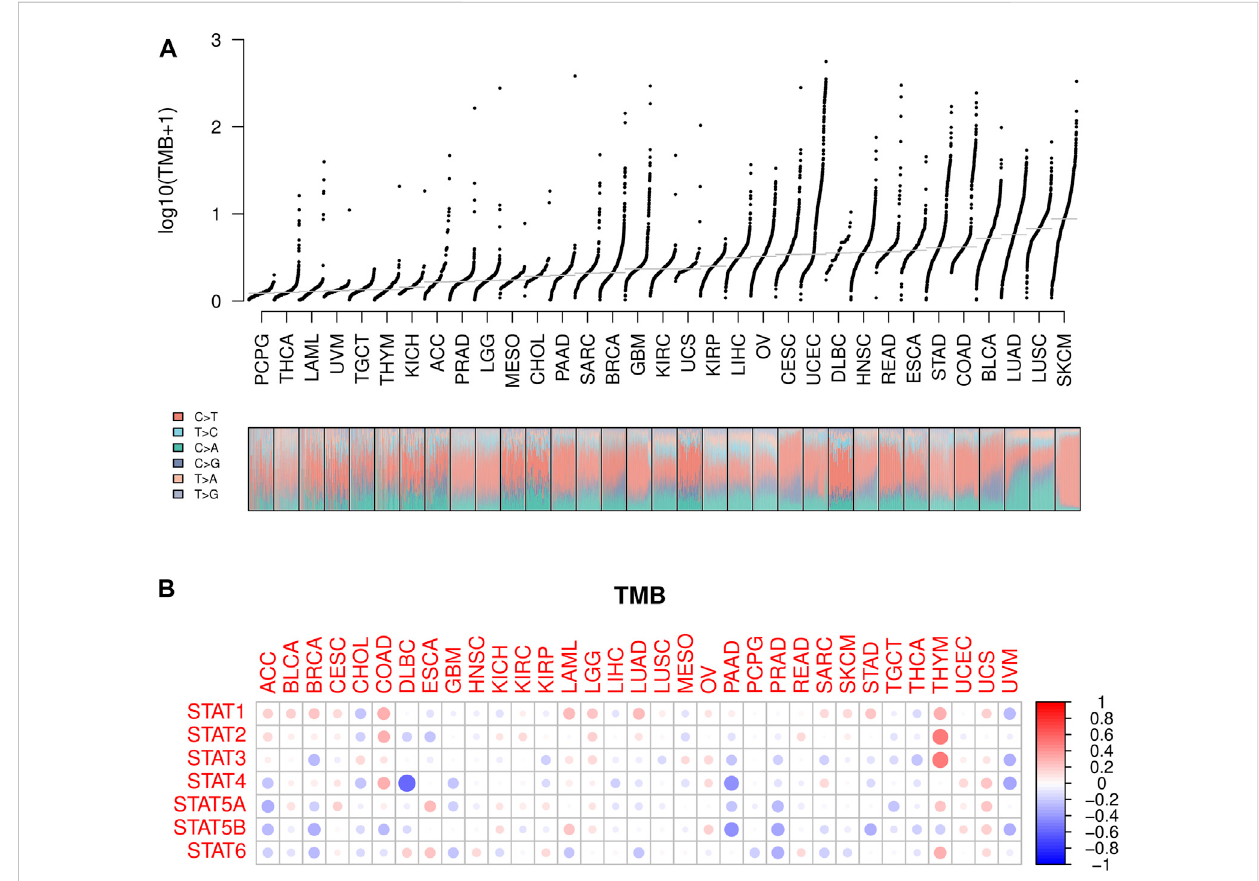
FIGURE 7 TMBanalysisofSTATsinpan-cancer. (A) TMBvalueswasshownintheformoflog10(TMB+1)in33typesofcancer,inwhichlowerTMBvalueswere identi fi ed in PCPG, THCA, and LAML while higher TMB values were revealed in SKCM, LUSC, and LUAD. (B) Heatmap demonstrating the correlations between STATs expression and TMB values, from which STAT4 expression was spotted to have a strong negative correlation with TMB value in DLBC, as well as STAT4 and STAT5B expression with TMB values in PAAD. Meanwhile, STAT1, STAT2, STAT3, and STAT6 expression were demonstrated to have positive correlations with TMB values in